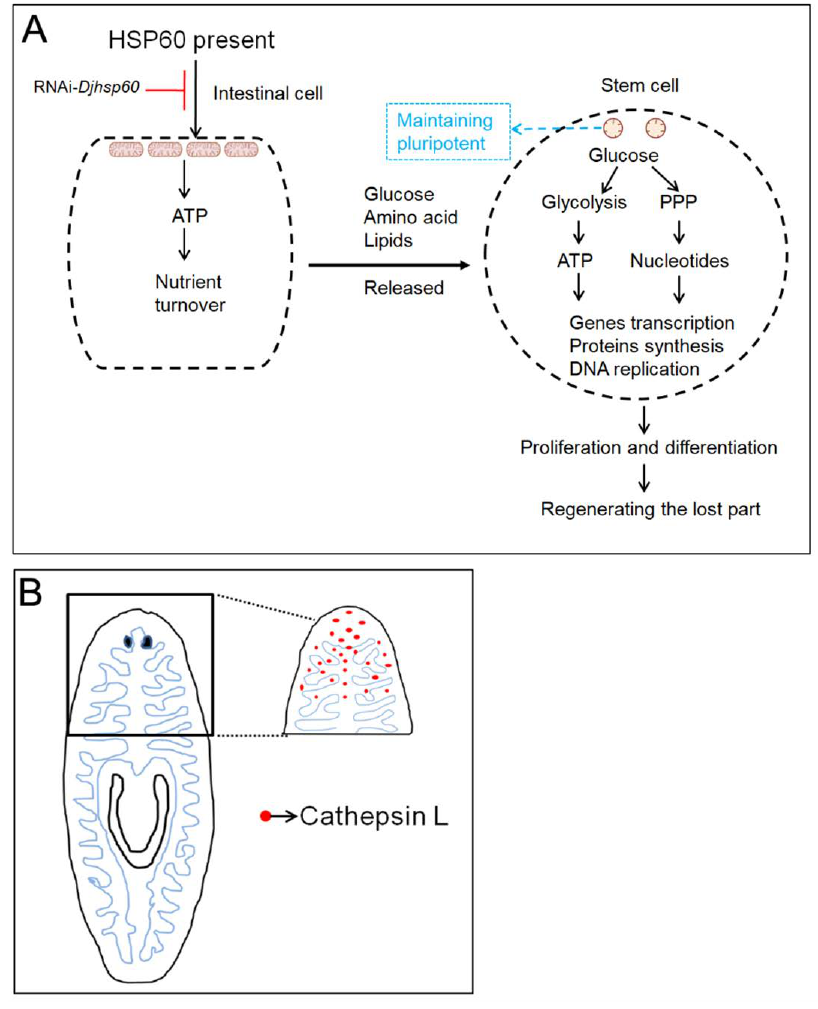
Figure 12. Proposed model illustrating the necessity of HSP60 in planarian regeneration and tissue homeostasis. ( A ) HSP60 functions in maintaining the integrity of mitochondria, which show distinct morphology and function in stem cells and intestinal cells. Intestinal cells depend on mitochondria to produce ATP for nutrient turnover, and to release nutrients for stem cells and other types of cells. Stem cells mainly depend on glycolysis to produce ATP for genes transcription and protein synthesis, and also depend on the pentose phosphate pathway (PPP) to produce nucleotides for DNA replication. Mitochondria in stem cells are related to maintaining pluripotency. ( B ) Intestinal branches can extend to the tip of planarian head. Activating and releasing of cathepsin L from intestinal cells induced by RNAi- Djhsp60 may be the reason for head